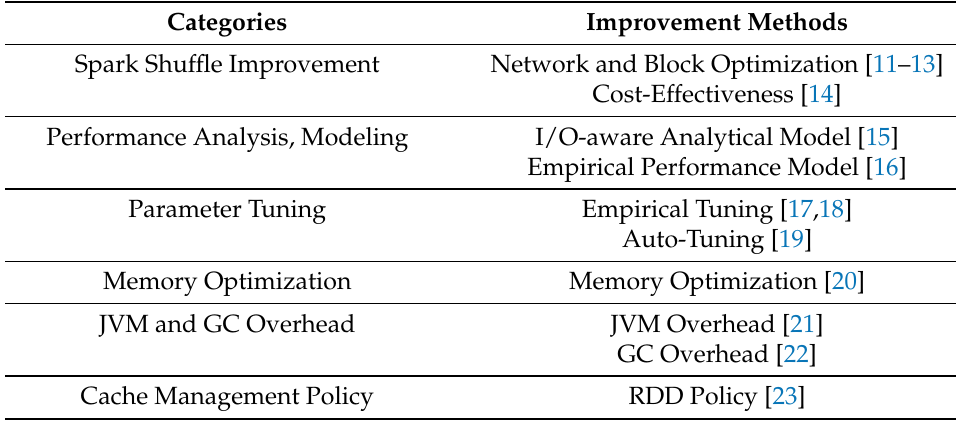
Table 1. Summary of related